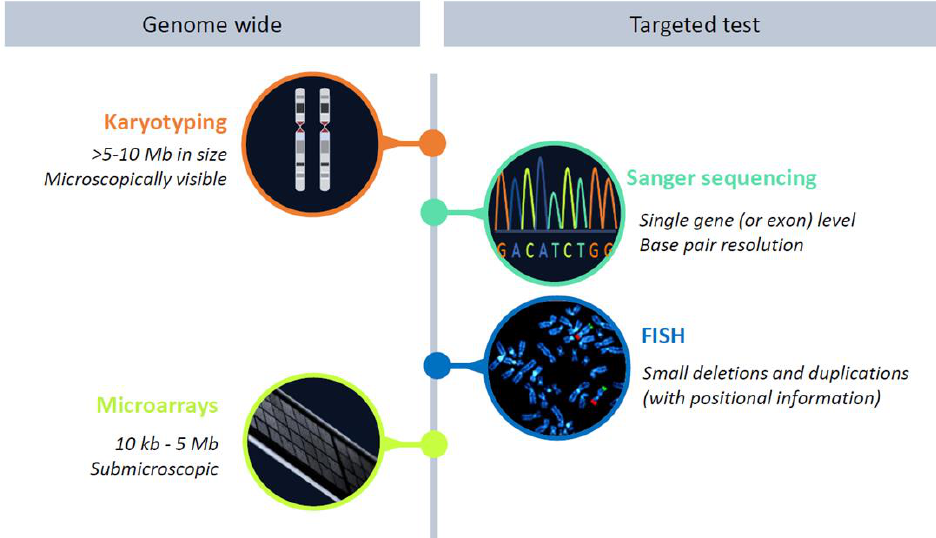
Figure 3. Schematic overview of the most commonly used cytogenetic and molecular genetic assays employed to elucidate the underlying genetic cause of ID in the pre-NGS era. Of note, genome-wide genetic assays can be used in both a genotype- and phenotype-first approach, whereas the targeted assays are mostly only used in a phenotype-first approach.